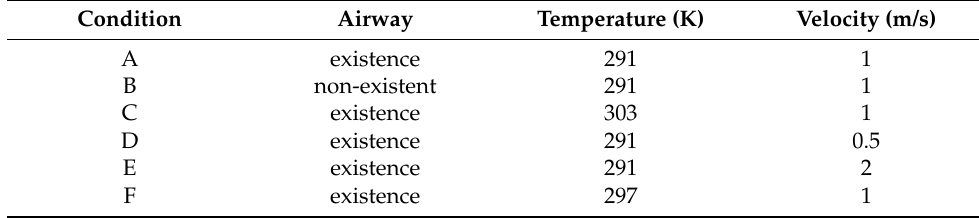
Table 1. Boundary condition setting for numerical